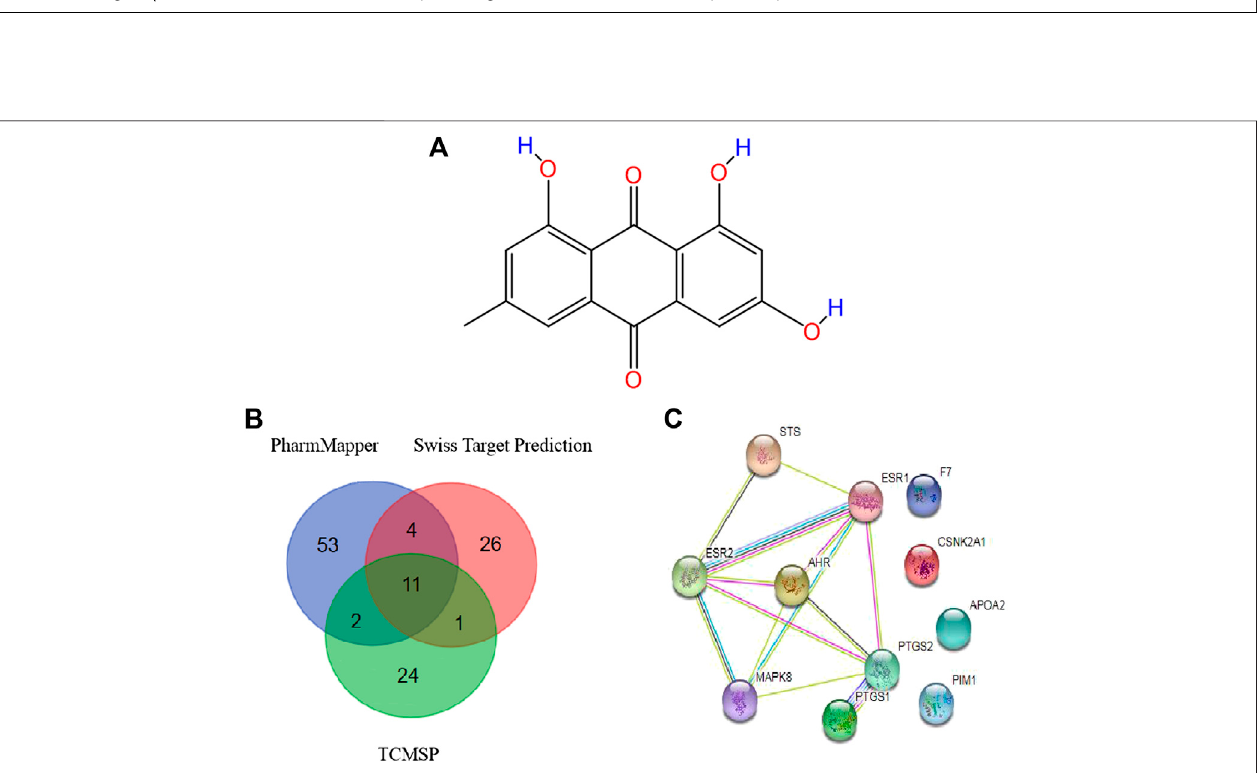
FIGURE4|(A) Structureofemodin (B) Potentialproteintargets ofemodinobtainedusingthePharmMapper,Swiss TargetPrediction,and TCMSPdatabases (C) PPI network of core targets.